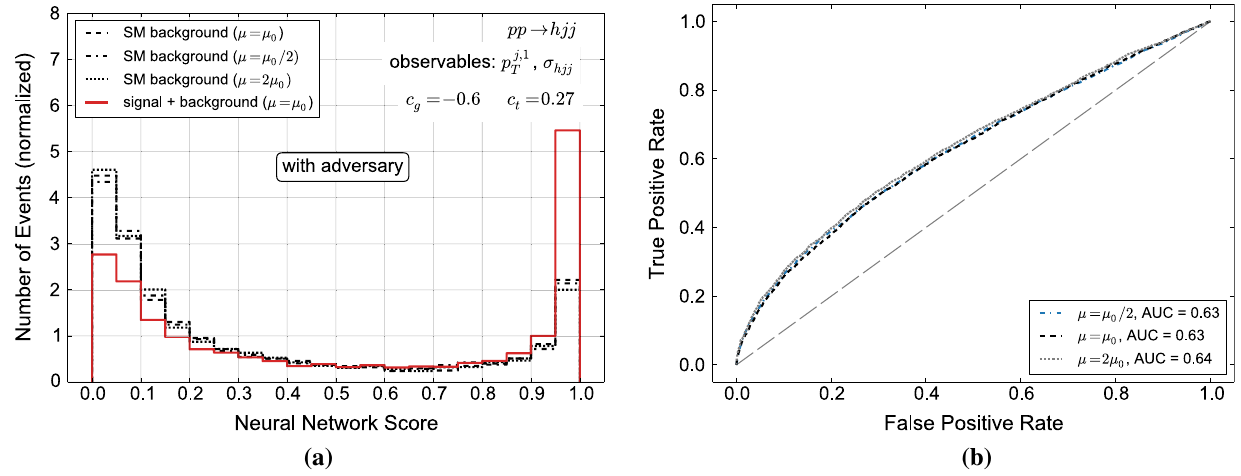
Fig. 5 Same as Fig. 4 but here the distributions were obtained by a classifier that had been trained using the adversarial setup. If the area under curve (AUC) is larger than 0.5, discrimination is